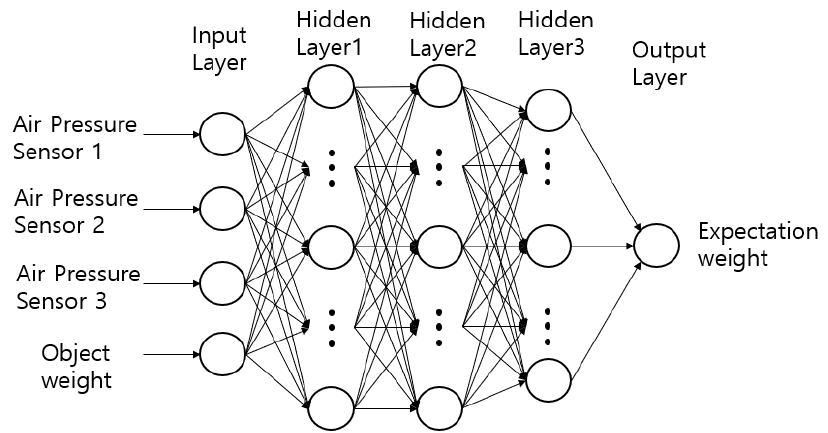
Figure 4. Weight sensing training with deep neural network.